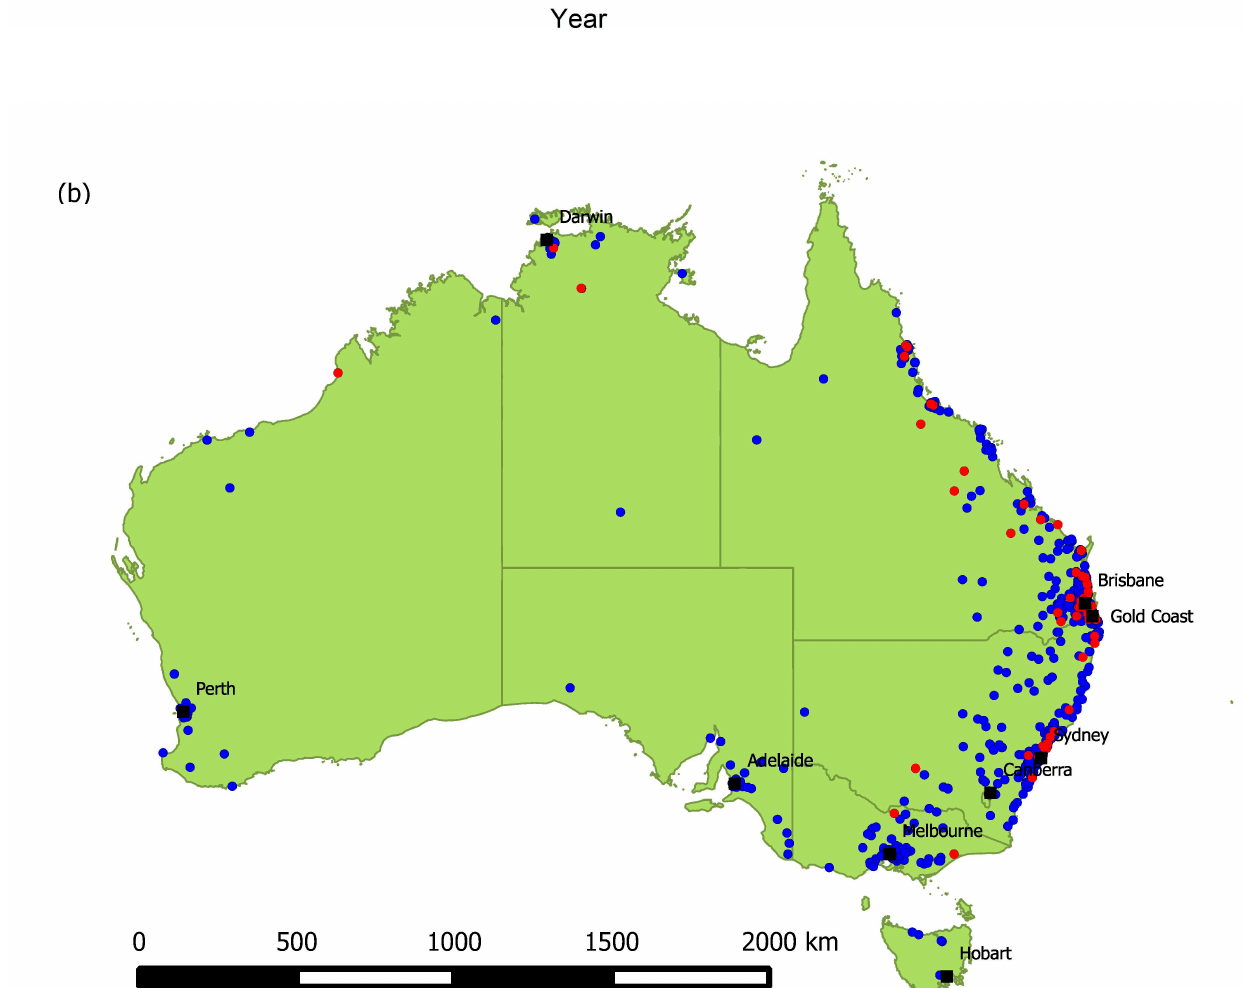
Figure 2. ( a ) Number of bats tested and their ABLV status per year, 2010–2016. ( b ) Locations from which bats were